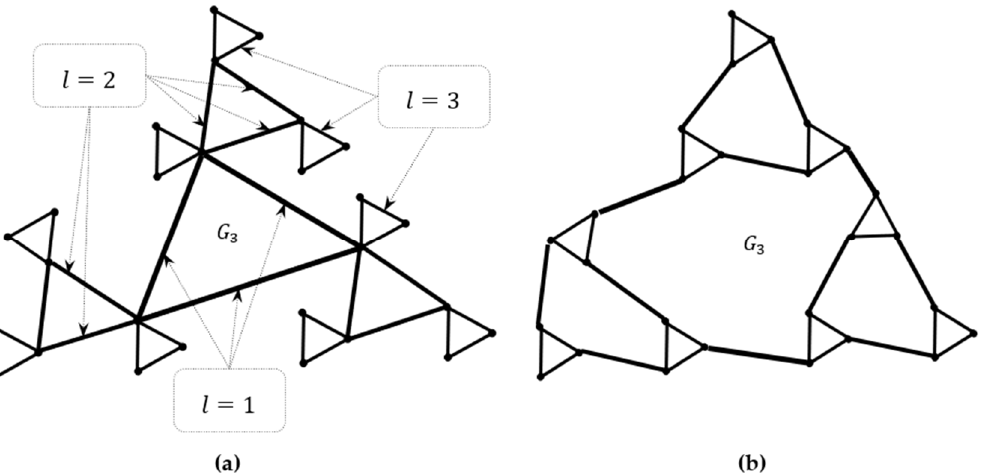
Figure 9. ( a ) Prefractal graph with preservation of adjacency of old edges. ( b ) Prefractal graph in which the old edges do not intersect.